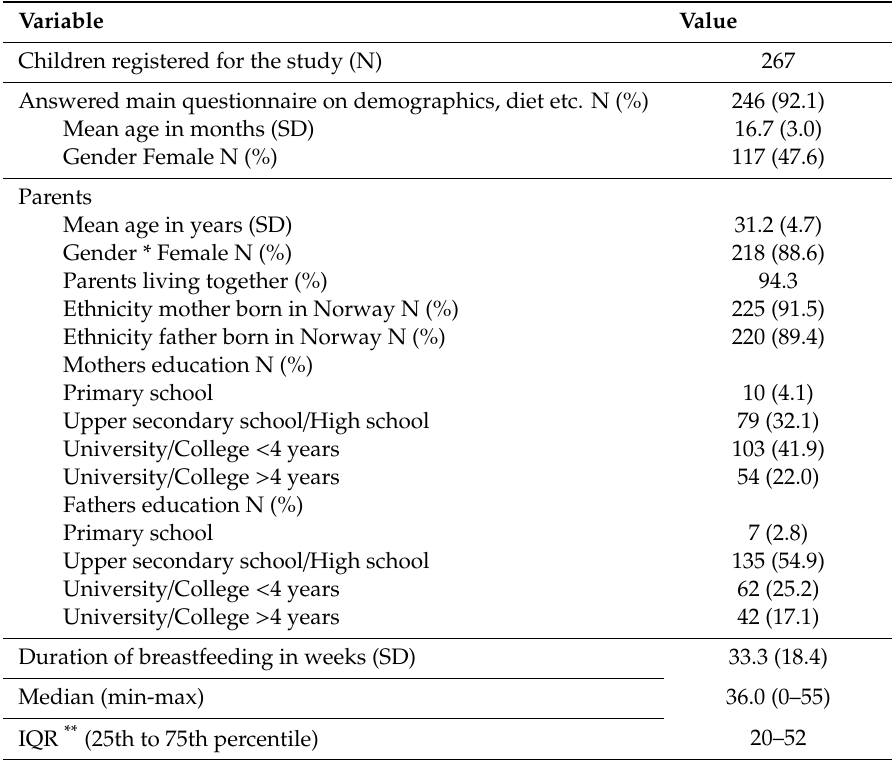
Table 1. Baseline characteristics of the study population.